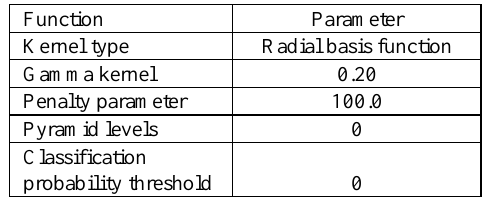
Table 4. Description of the selected parameters with the